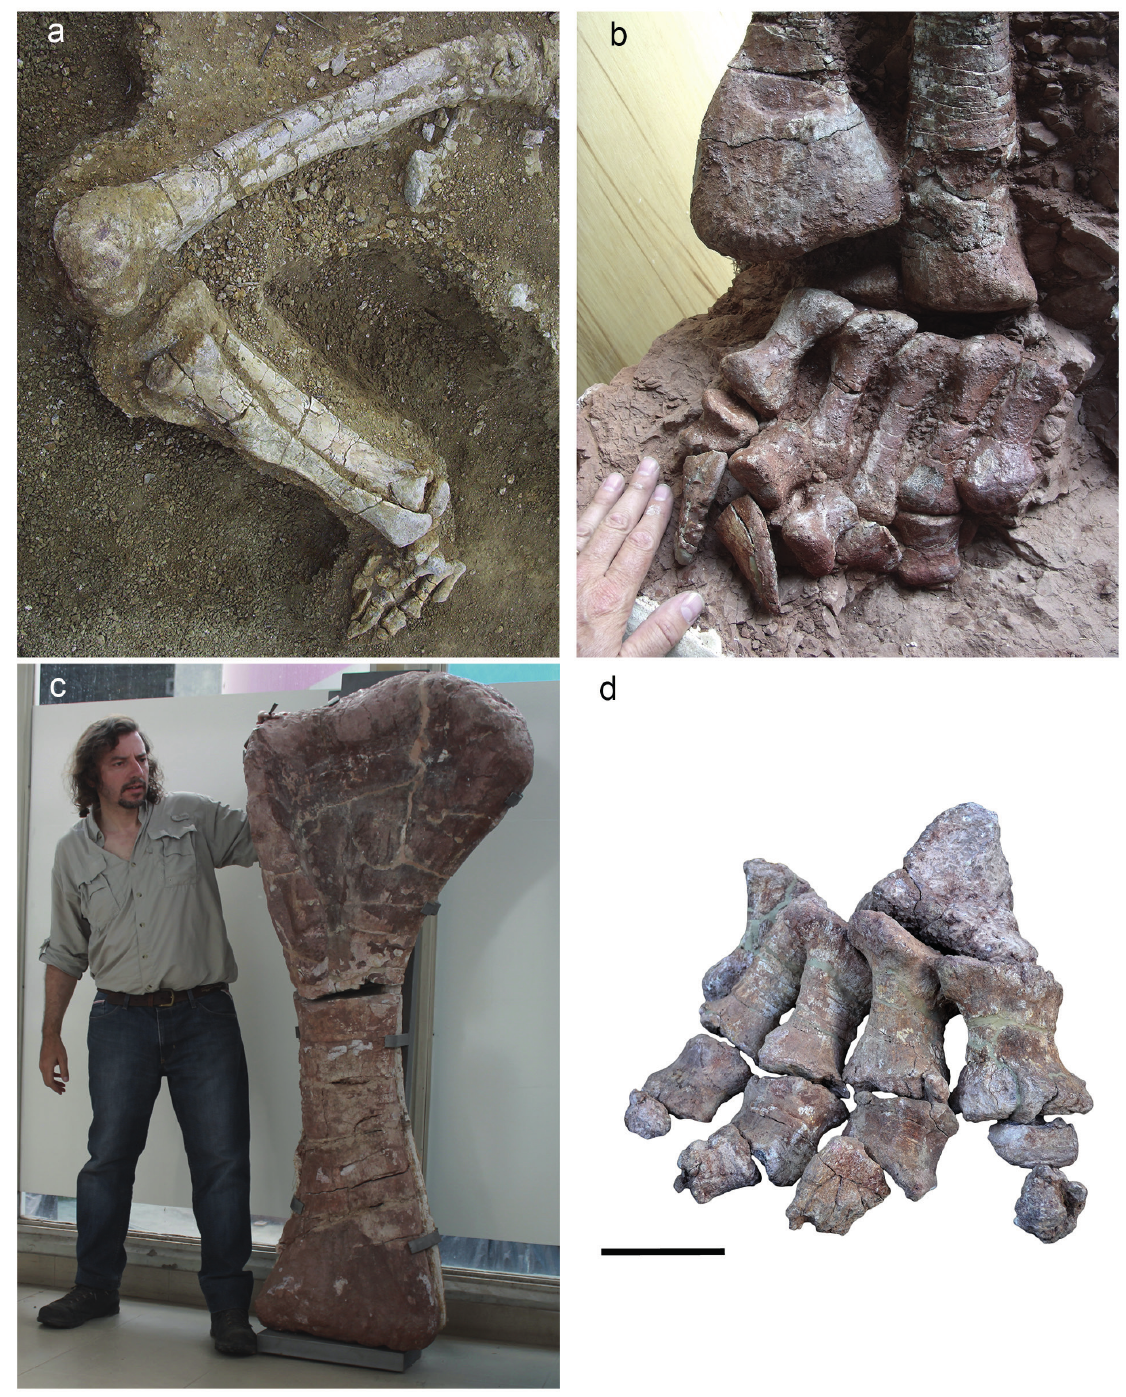
Figure 1 – recent discoveries of appendicular skeletal elements of Late Cretaceous titanosaurian sauropods from the Neuquén Basin of southern Argentina. ( a ) complete and articulated left hind limb of the unnamed La Invernada taxon (MUCPv-1533), ( b ) complete and articulated distal left hind limb of the unnamed Agua del Padrillo taxon (UNCUYO-LD 313), ( c ) right humerus of Notocolossus gonzalezparejasi (UNCUYO-LD 301), ( d ) complete and articulated right pes of Notocolossus gonzalezparejasi (UNCUYO-LD 302). Scale bar equals 10 cm in ( d